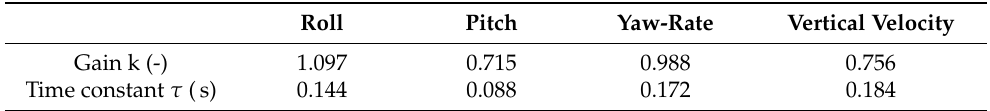
Table 2. First order model parameters for each axis.